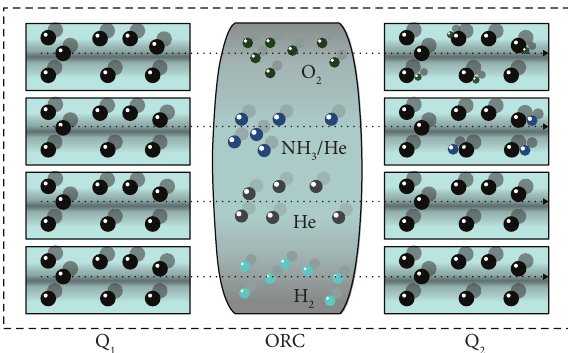
Figure 1: Interference cancellation model of the MS/MS mode. The ions collided with gas in the